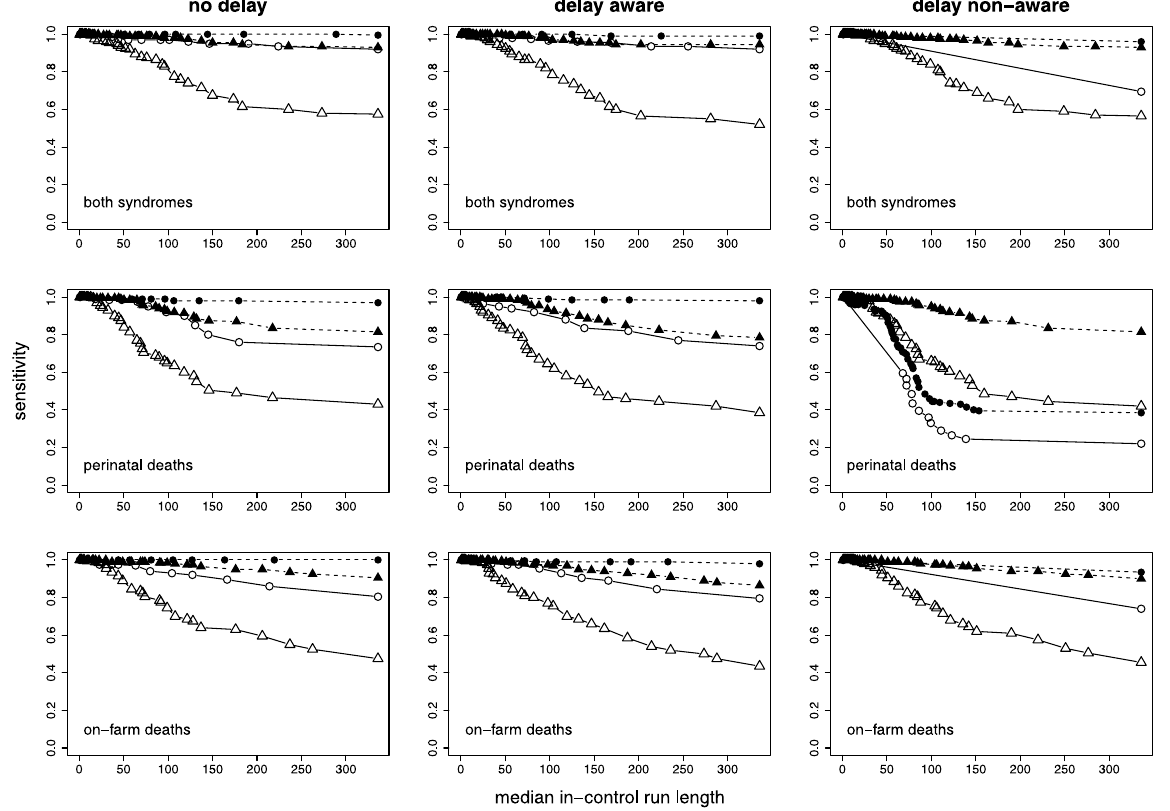
Figure 5. Sensitivity and median in-control run length for a range of alarm thresholds based on the value of evidence (circles) and the z-score (triangles), summarised for the smaller (empty symbols with solid lines) and larger (filled symbols with dashed lines) outbreak type. Values in the top right corner of the graph tend towards an ideal system with sensitivity = 1 (i.e. all outbreak signals are detected) and run length = 336 days (i.e. no false alarm occurs within 1